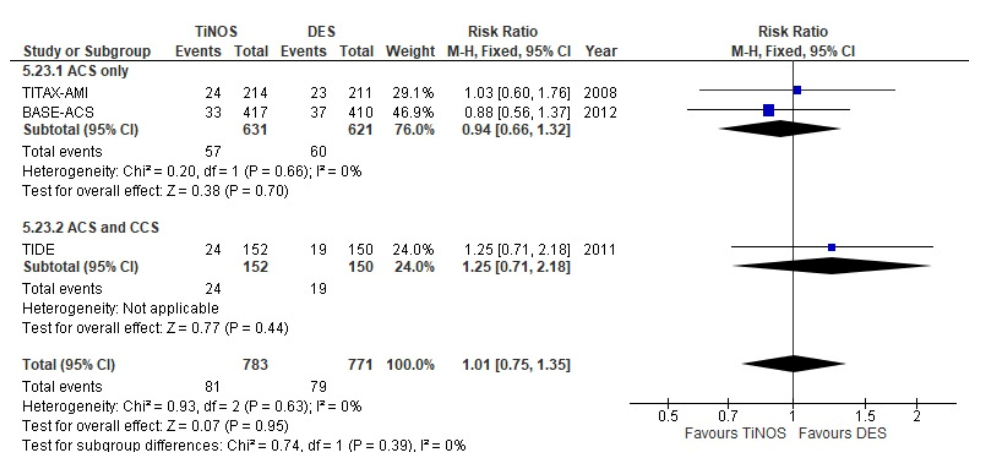
Figure 8. TLR—1 year.